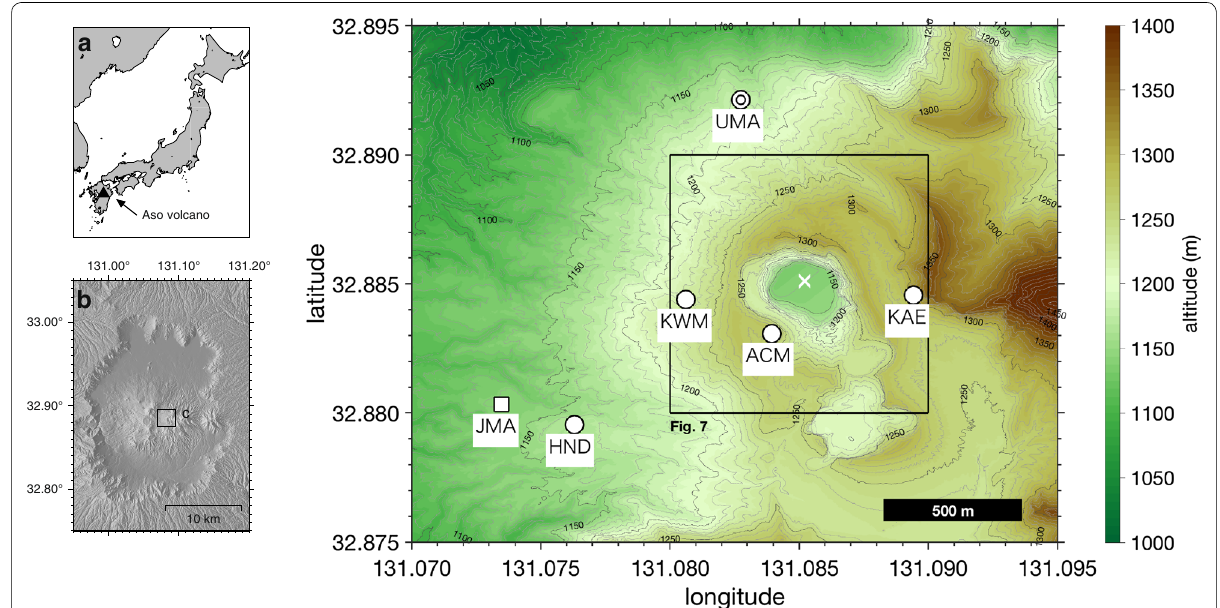
Fig. 1 Infrasound stations deployed at Aso volcano. a Map of Aso volcano (Aso caldera) in SW Japan. b Active crater of the volcano (Nakadake-1st-crater) is located at the center of the caldera. c Infrasound stations indicated by circles are installed around the active crater, where a cross marks the eruptive vent. The UMA station (double circle) is also equipped with a broadband seismometer. A square indicates a weather station of